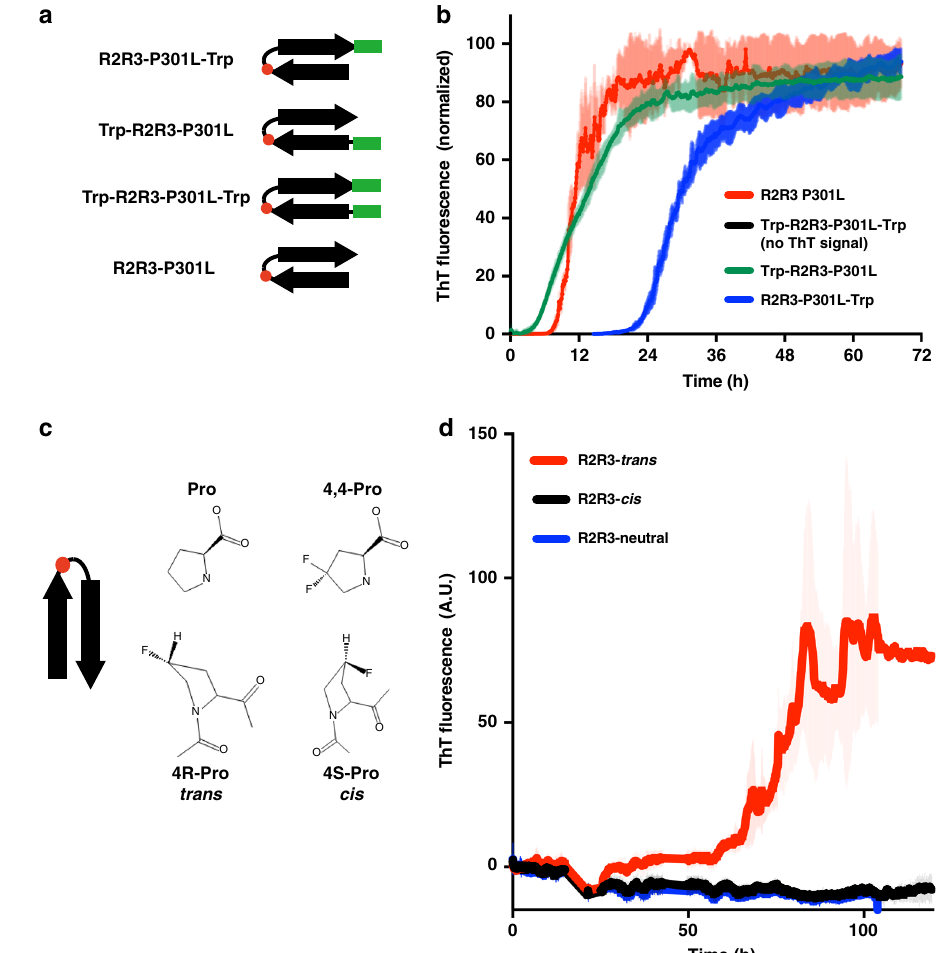
Fig. 7 Enhancing β -hairpin structure rescues spontaneous aggregation phenotypes. a Cartoon schematic representation of the tryptophan zipper motif (green bar) and controls used to stabilize a β -hairpin structure in an R2R3-P301L peptide fragment (Supplementary Table 2). b Aggregation reactions of the tryptophan zipper peptide and controls measured by ThT fl uorescence. The Trp-R2R3-P301L-Trp fragment peptide yielded no detectible ThT signal change (less than twofold ratio to background signal) over the course of the experiment (see Supplementary Data 1) ThT signals are shown as average of triplicates with standard deviation and were normalized to the maximum for each condition. c Schematic of proline and fl uorinated proline analogs used to generate cis and trans proline conformers at the position corresponding to P301 (red circle) in peptide models. d ThT aggregation reactions of the cis , trans , and neutral proline analogs substituted into the R2R3 peptide fragment. ThT signals are an average of six independent experiments with standard deviation